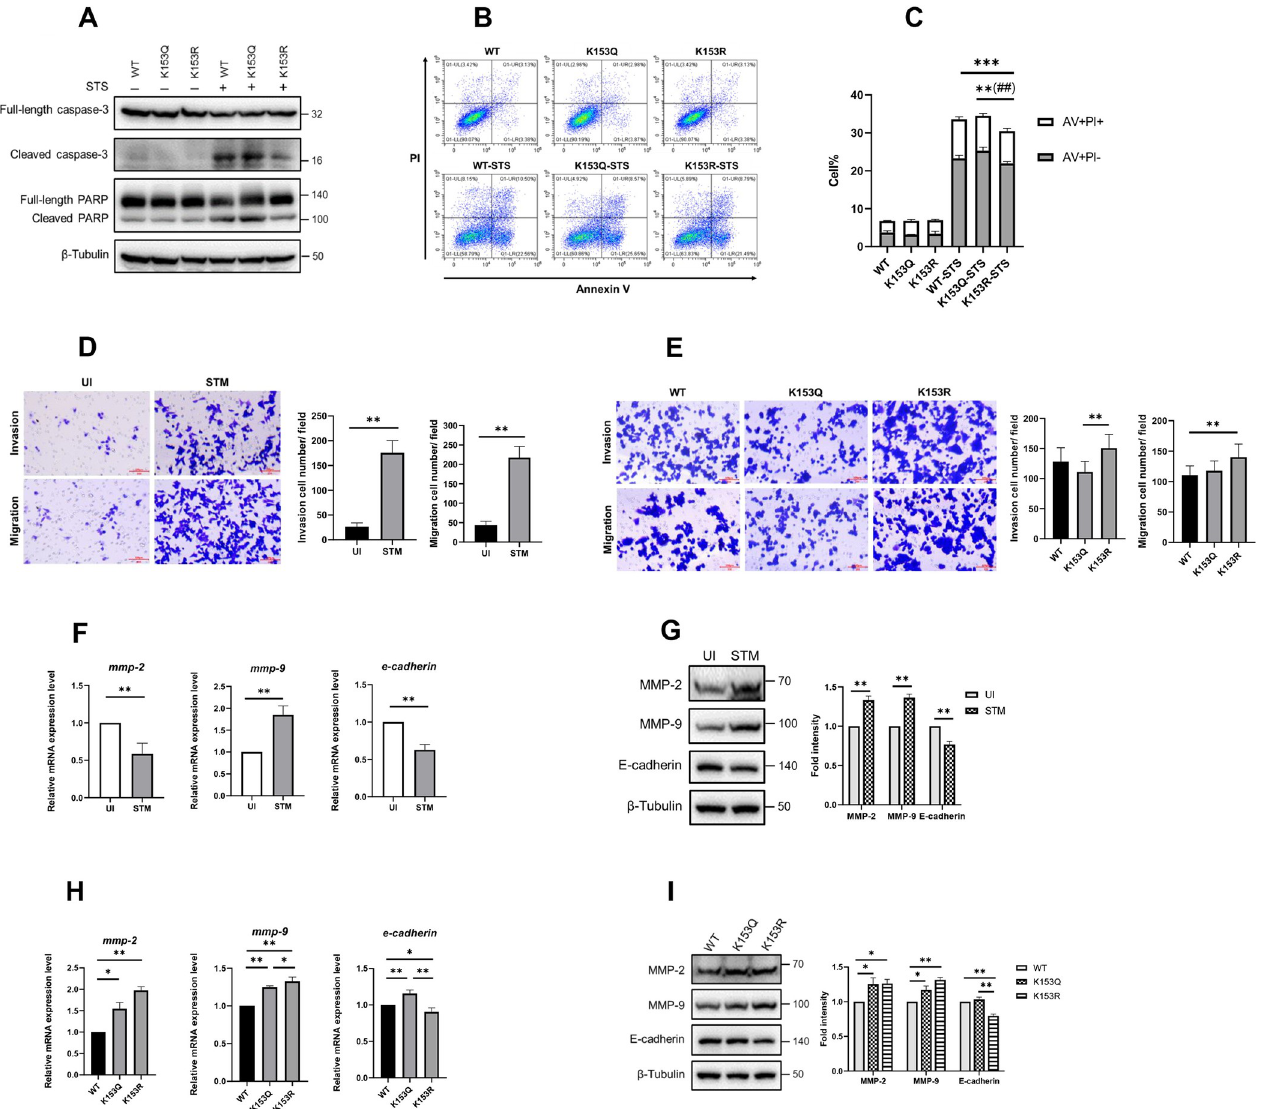
Fig 6. Unacetylated CDC42 K153 is correlated with enhanced tumorigenesis phenotype of HCT116 cells. HCT116 cells stably expressing CDC42-WT, CDC42 K153Q or CDC42 K153R were analyzed for apoptosis as followed: (A) The level of full-length or cleaved caspase-3 or PARP in cells treated with 4 μ M staurosporine (STS) for 4 h was determined by WB. (B) Cells were treated with 0.4 μ M STS for 24 h, and the level of surface exposure of the apoptosis signature phospholipid phosphatidyserine (PS) was determined by Annexin V (AV) staining followed by flow cytometry analysis. Propidium iodide (PI) was used to exclude necrotic cells. (C) Percentage of AV+PI- (gray bars) and AV+PI+ (white bars) cells. Asterisks represent p values for all AV+ cells, and octothorpes represent p values for AV+ and PI- cells ( �� p < 0.01, ��� p < 0.001, ## p < 0.01). (D) Migration and invasion assays of HCT116 cells infected with S . Typhimurium. (E) Migration and invasion assays of HCT116 cells stably expressed CDC42-WT, CDC42 K153Q, or CDC42 K153R. (F) Determination of the mRNA expression level of mmp-2 , mmp-9 , and e-cadherin by quantitative real-time PCR in HCT116 cells infected with S . Typhimurium. (G) Determination of MMP- 2, MMP-9, and E-cadherin by WB in HCT116 cells during S . Typhimurium infection, and densitometry analysis was shown (Right). �� p < 0.01. (H) Determination of the mRNA expression level of mmp-2 , mmp-9 , and e-cadherin by quantitative real-time PCR in HCT116 cells stably expressing WT or QR mutants of CDC42 K153. (I) Determination of MMP-2, MMP-9, and E-cadherin by WB in HCT116 cells stably expressing CDC42-WT, CDC42 K153Q or CDC42 K153R, and densitometry analysis was shown (Right). � p < 0.05, �� p <